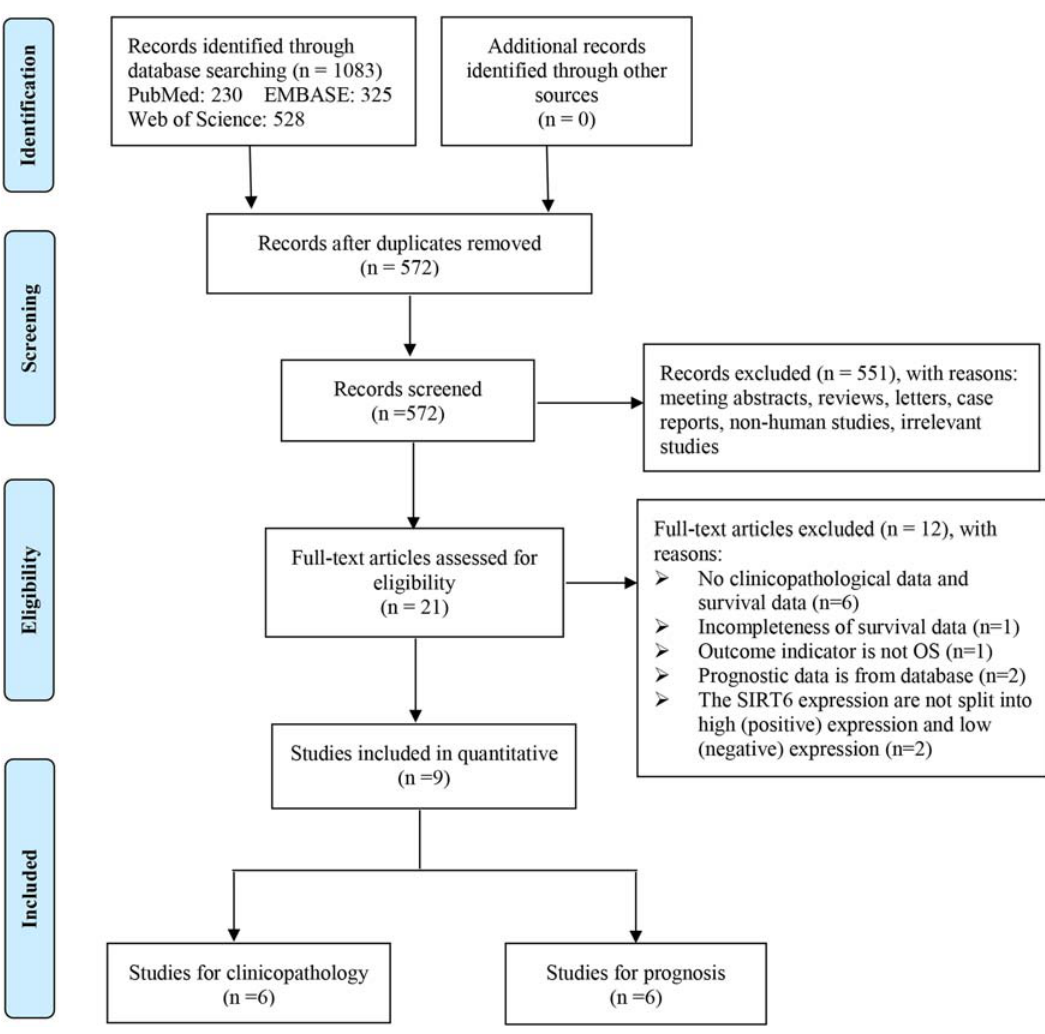
Figure 1: Flow diagram of study search and selection process.